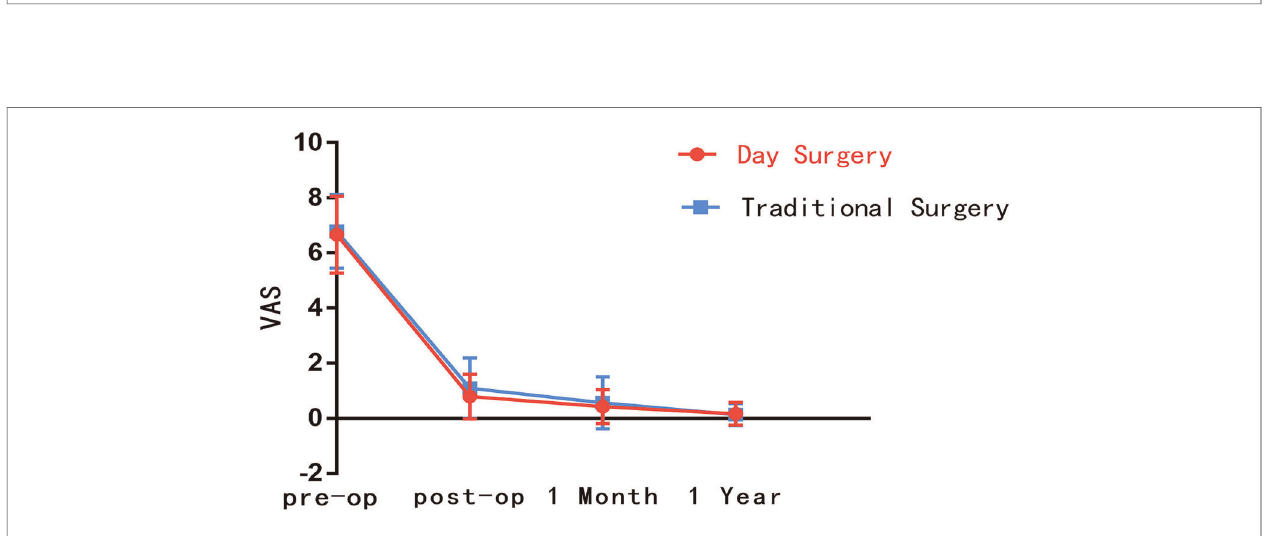
FIGURE 2 | Comparison of VAS for back pain between DS group and TS